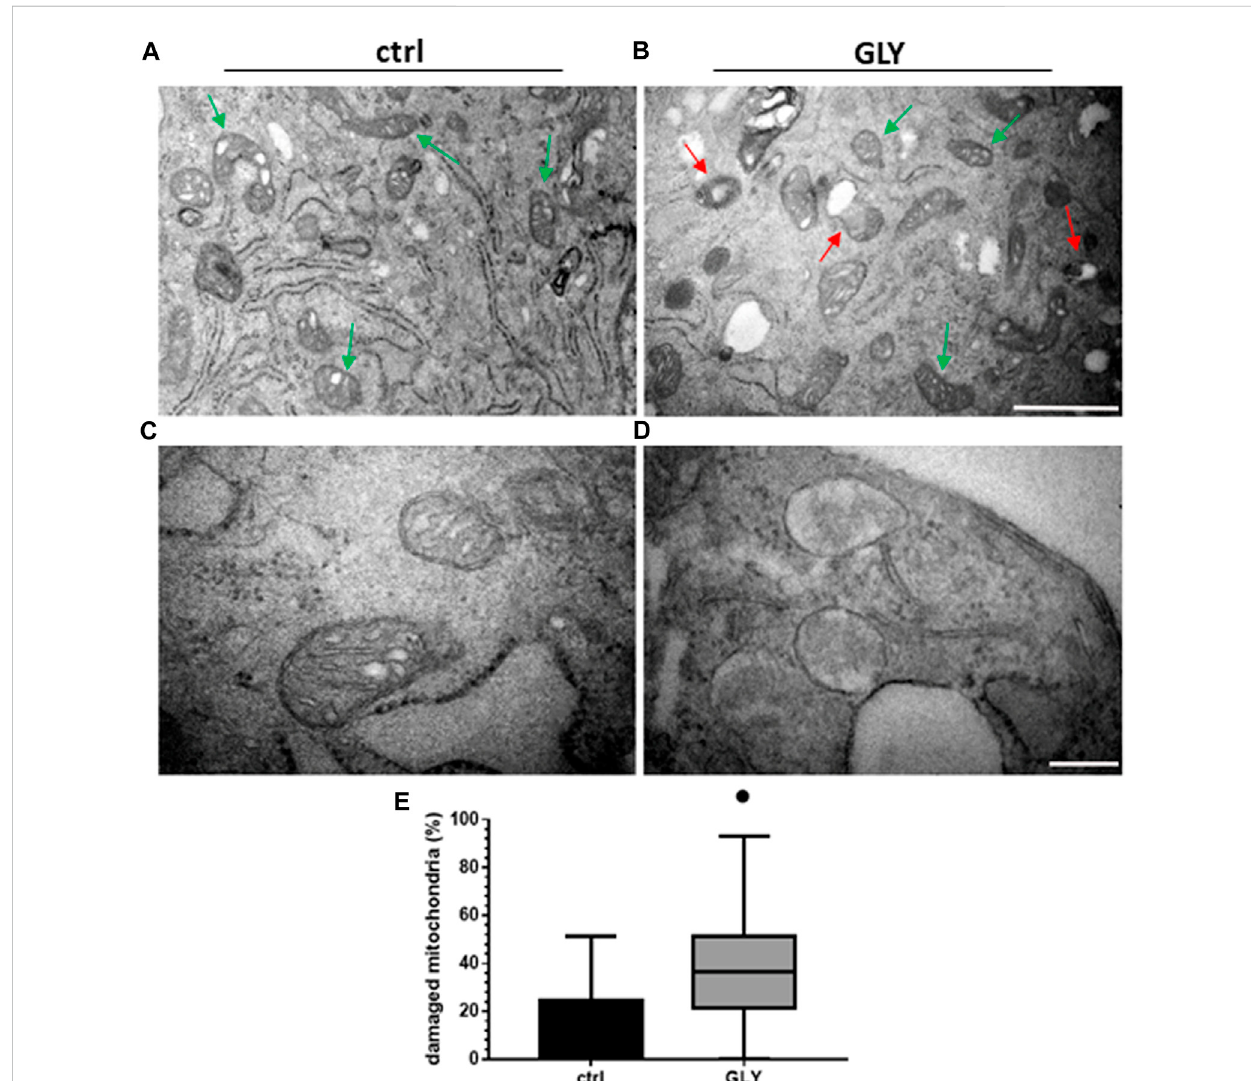
FIGURE 5 Ultrastructural analysis and mitochondria quanti fi cation. The fi gure shows: (A) Ultrastructure of HM in H9c2 cells control group (green arrows); (B) morphology of DM (red arrows) and HM (green arrows) in GLY group (10 mM, 1 h of treatment) (Scale bar = 1 µm); (C) higher magni fi cation of HM in control group and (D) higher magni fi cation of DM in GLY group (Scale bar = 0.2 µm). In ( E) the relative boxplots of the mitochondrial count are shown. p -values: C < 0.0001 vs .